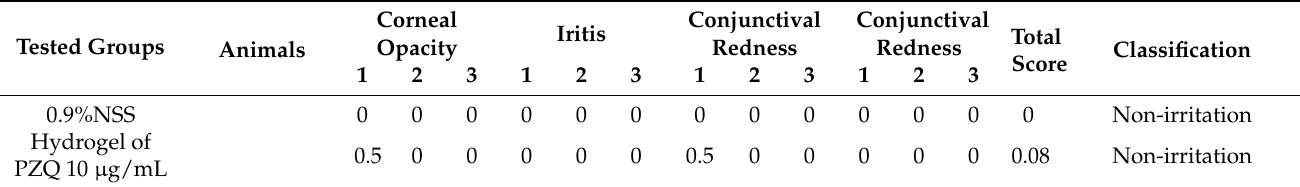
Table 1. The grades of ocular reactions (cornea, conjunctivae, and iris) from chicken eyes exposed to negative control (0.9%NSS) and Hydrogel of PZQ 10 µ g/mL for 21